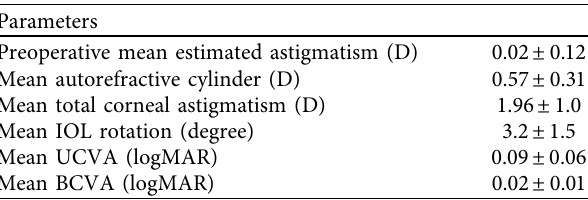
Table 2: Postoperative results of patient 2months after toric IOL implantation.